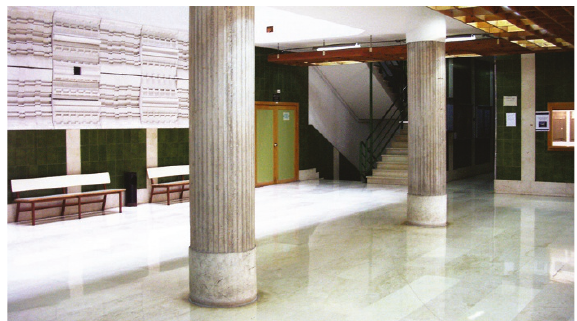
Figure 10: Experimental site.